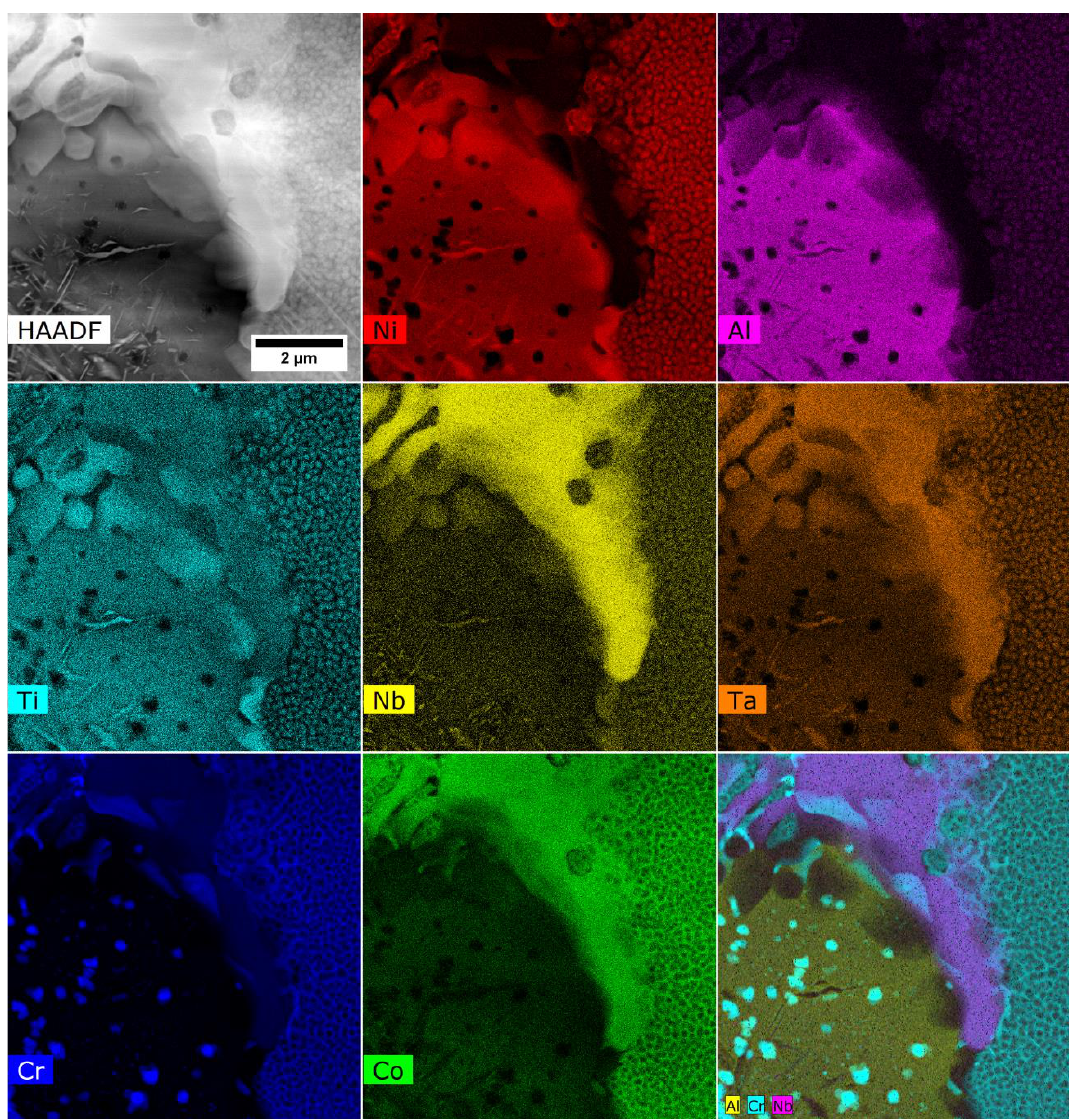
Figure 14. The distribution of the alloying elements in the interdendritic spaces of superalloy A9, STEM-HAADF.